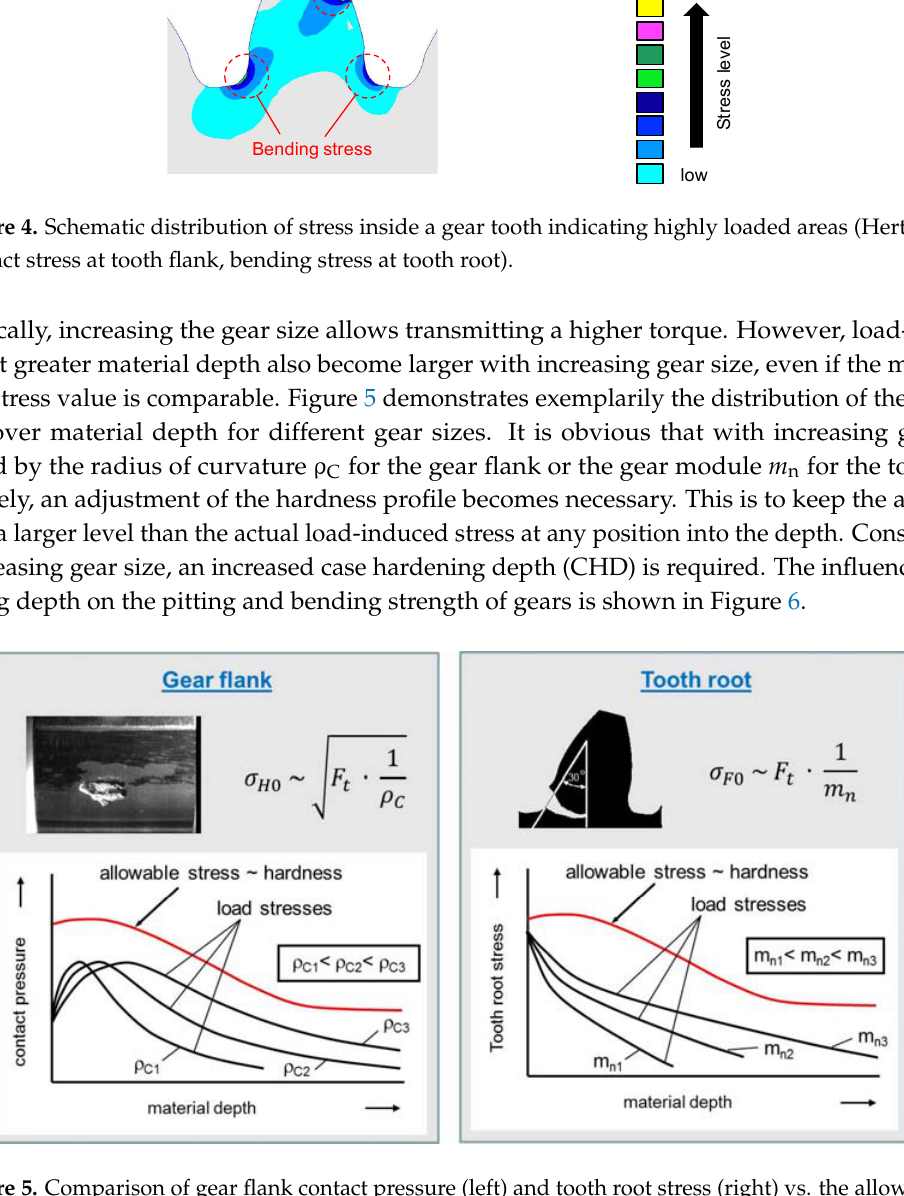
Figure 5. Comparison of gear flank contact pressure (left) and tooth root stress (right) vs. the allowable stress over material depth depending on the gear size represented by the curvature ρ C and module m n for a given tangential driving force F t [7].